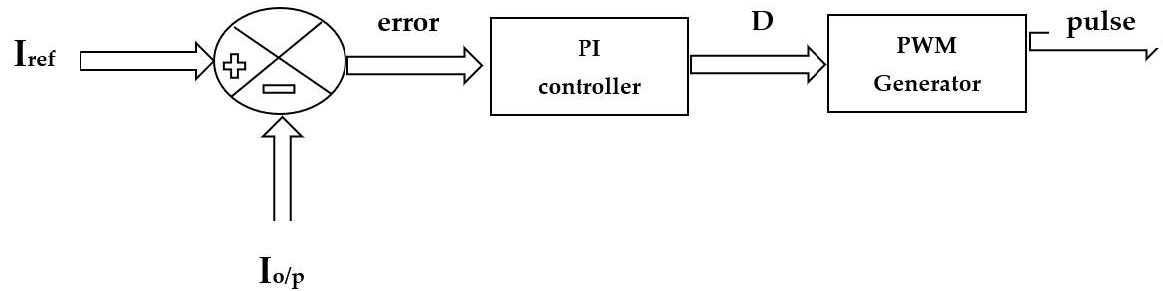
Figure 8. Buck converter controller.